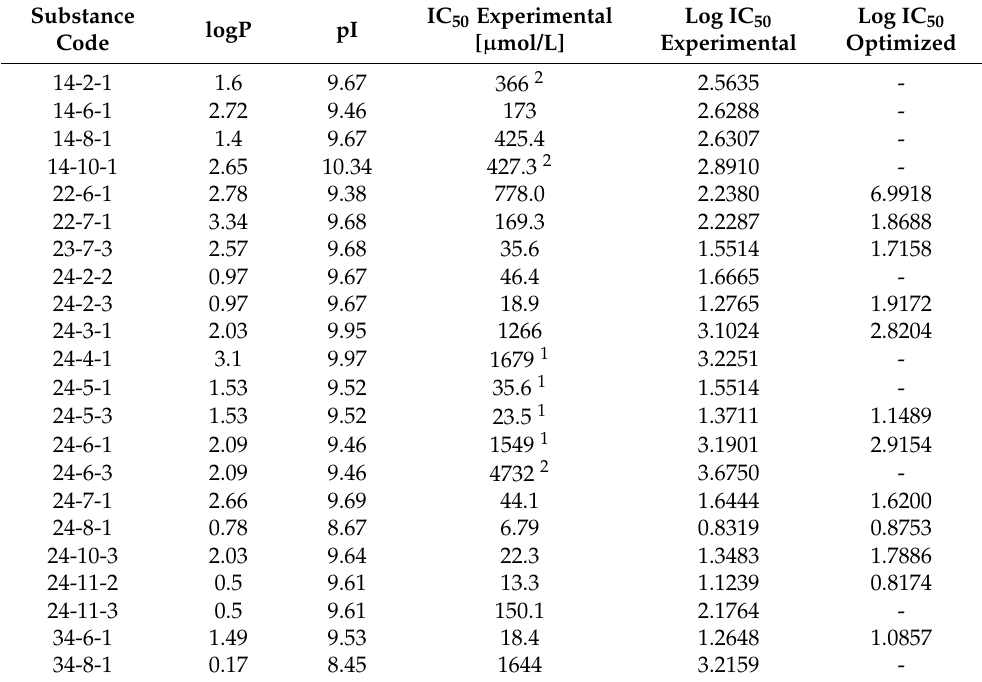
Table 2. Inhibitory activity of basically substituted acetamidoacetophenones and their semicarbazones and thiosemicarbazones expressed as IC 50 in µ mol/L, and their logarithms and values of computed physical parameters used for construction of QSAR Equation (2). Optimized values of log IC 50 are listed only for compounds that were finally used for the construction of Equation (2) (see the